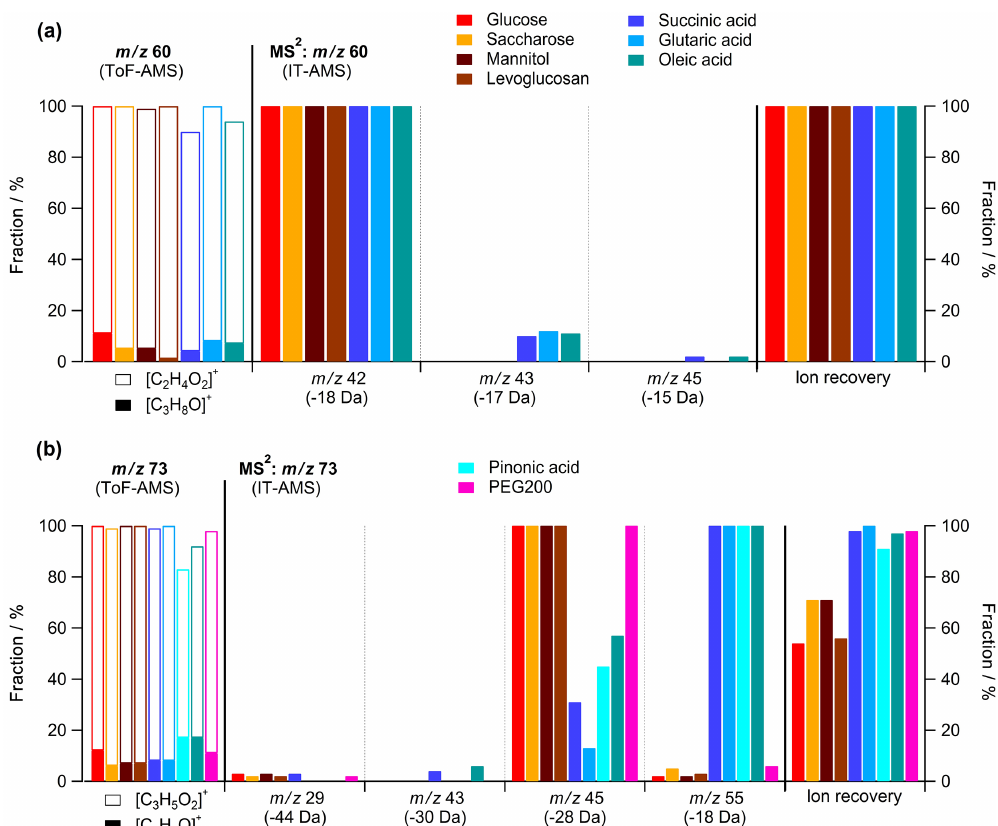
Figure 7. Results of studies on (a) m/z 60 and (b) m/z 73 for various compounds. On the left, the relative contributions of [C 2 H 4 O 2 ] + and [C 3 H 8 O] + to m/z 60 and of [C 3 H 5 O 2 ] + and [C 4 H 9 O] + to m/z 73 are given (from ToF-AMS measurements; the difference to 100% is due to one or several other ions contributing little to the respective m/z) . On the right, the results from IT-AMS MS 2 studies on these ions are summarised. For each investigated compound, the signal intensity of the fragment ions (relative to the signal intensity of the most abundant fragment) and the ion recovery are given. Not shown are fragments accounting for less than 1% and, for the MS 2 experiment on m/z 73, a small contribution observed at fragment ion m/z 61 for glucose (2% relative